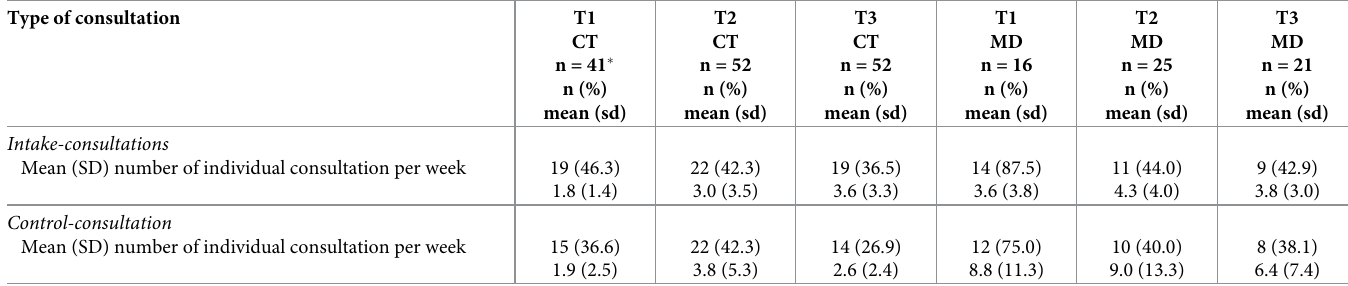
Table 3. Mean number of individual intake- and control